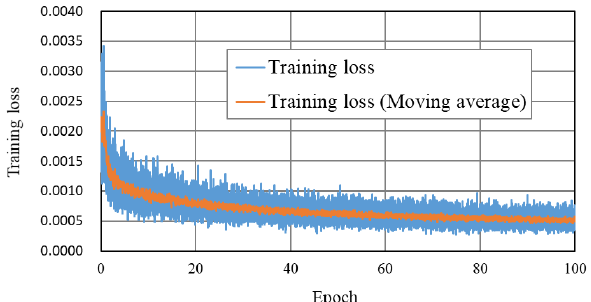
Figure 4. Training loss